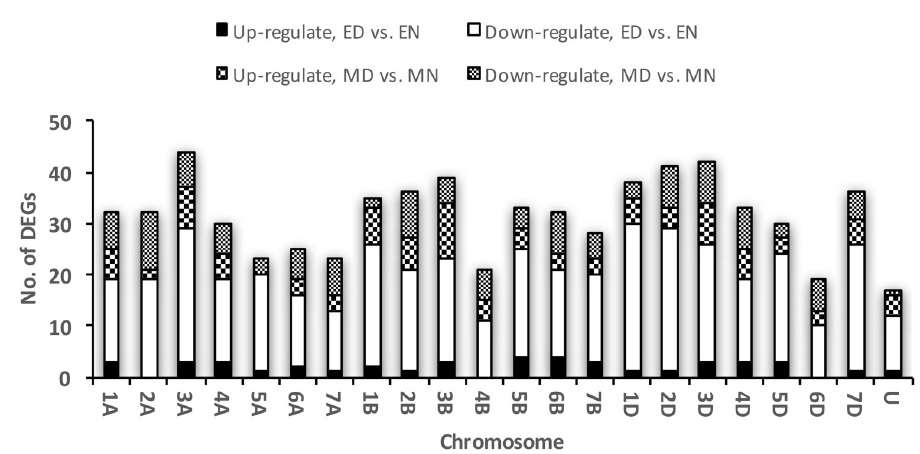
Fig 5. Distribution of DEGs across the wheat genome. Number of DEGs that are up or down-regulated in drought tolerance and drought sensitive genotype roots are shown in genome A, B and D. ED, L-82 under drought and EN, L- 82 under normal conditions. MD, Marvdasht under drought and MN, Marvdasht under normal